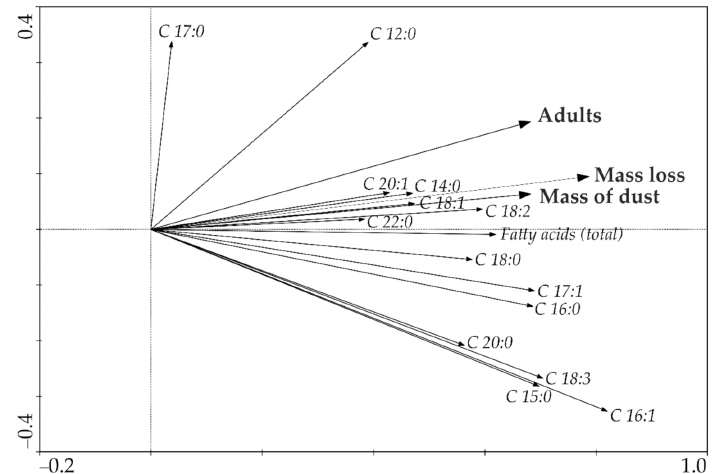
Figure 2. Redundancy analysis diagram (RDA) presenting correlations between analysed param- eters pertaining to the development of S. granarius and the content of fatty acids in the analysed wheat